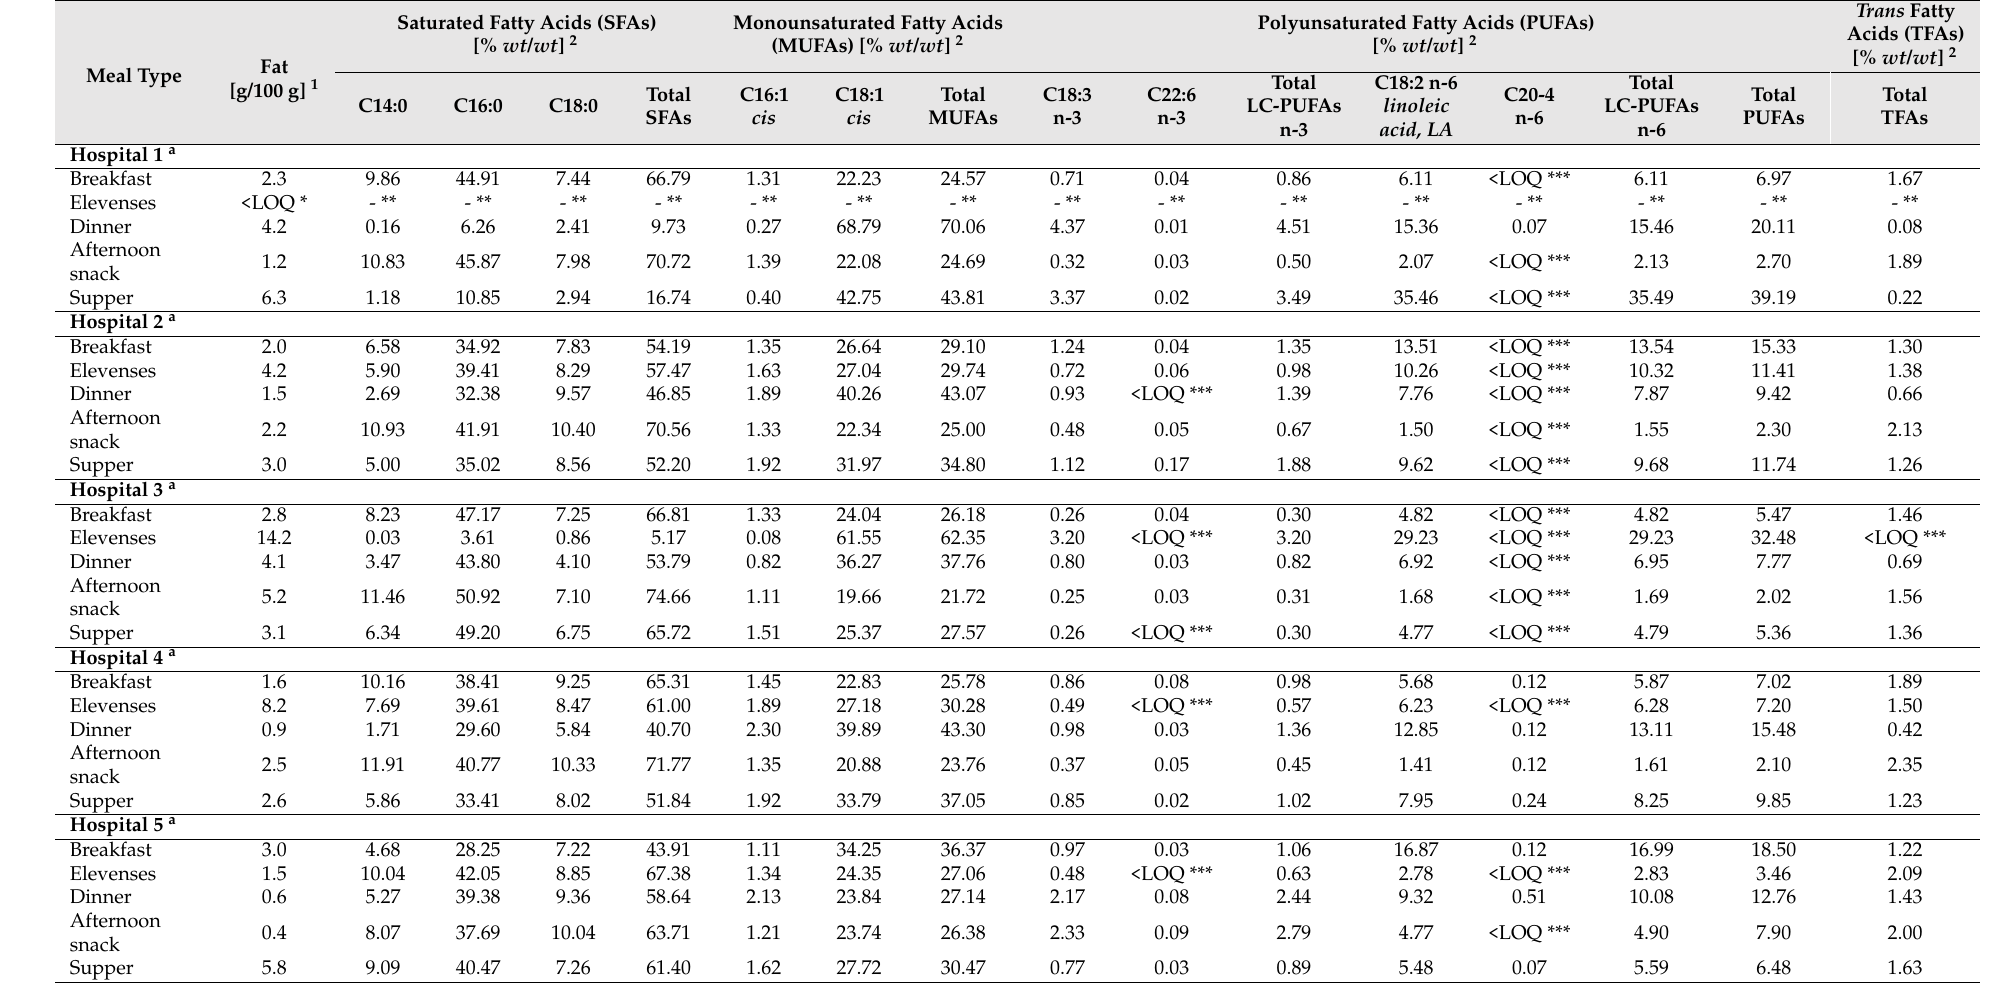
Table 2. Comparison of fat 1 and fatty acid 2 content in individual meals of the hospital